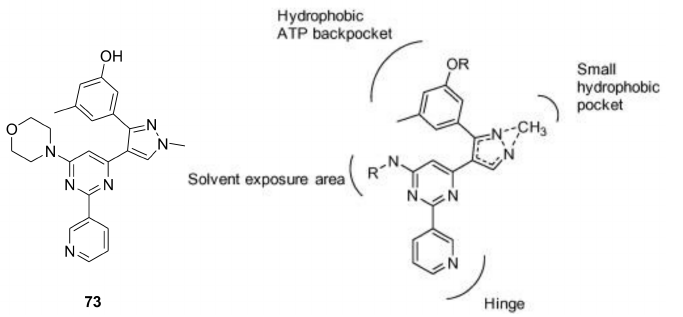
Figure 76. Structure of compound 73 and a simplified top view of a general scheme depicting the binding mode of trisubstituted prazoles in ROS1 and key interactions involved [86].